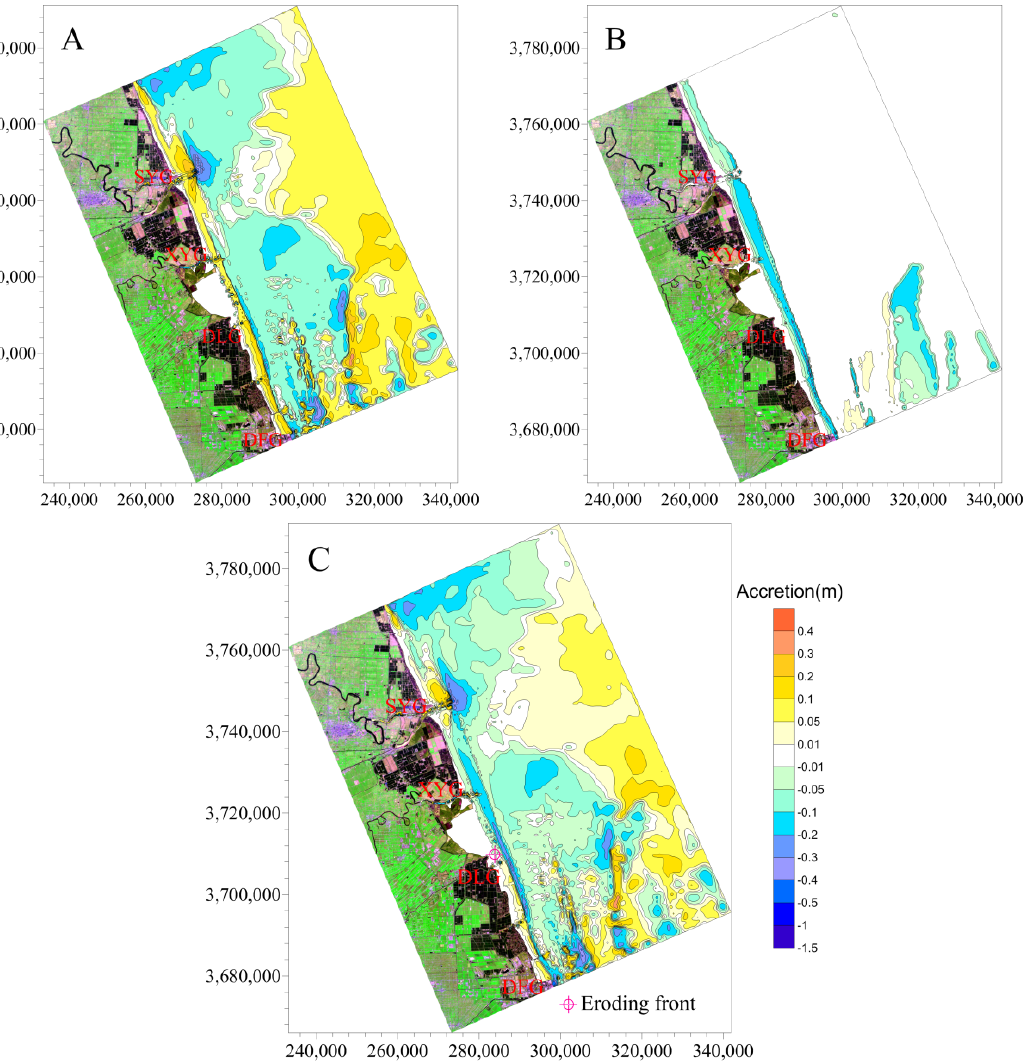
Figure 10. Yearly morphological adjustment in 2019 by solely tide ( A ) and wave force alone ( B ) and the net output ( C ). The coordinate axis unit is UTM (m).